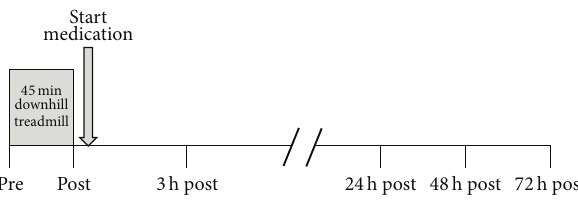
Figure 2: Experimental design. The figure shows the different time points of data collection. On day one, the data collection was performed immediately before, immediately after, and three hours after exercise (45min downhill running). Follow-up visits were performed 24 h, 48 h, and 72 h after exercise. The intake of the study medication started directly after